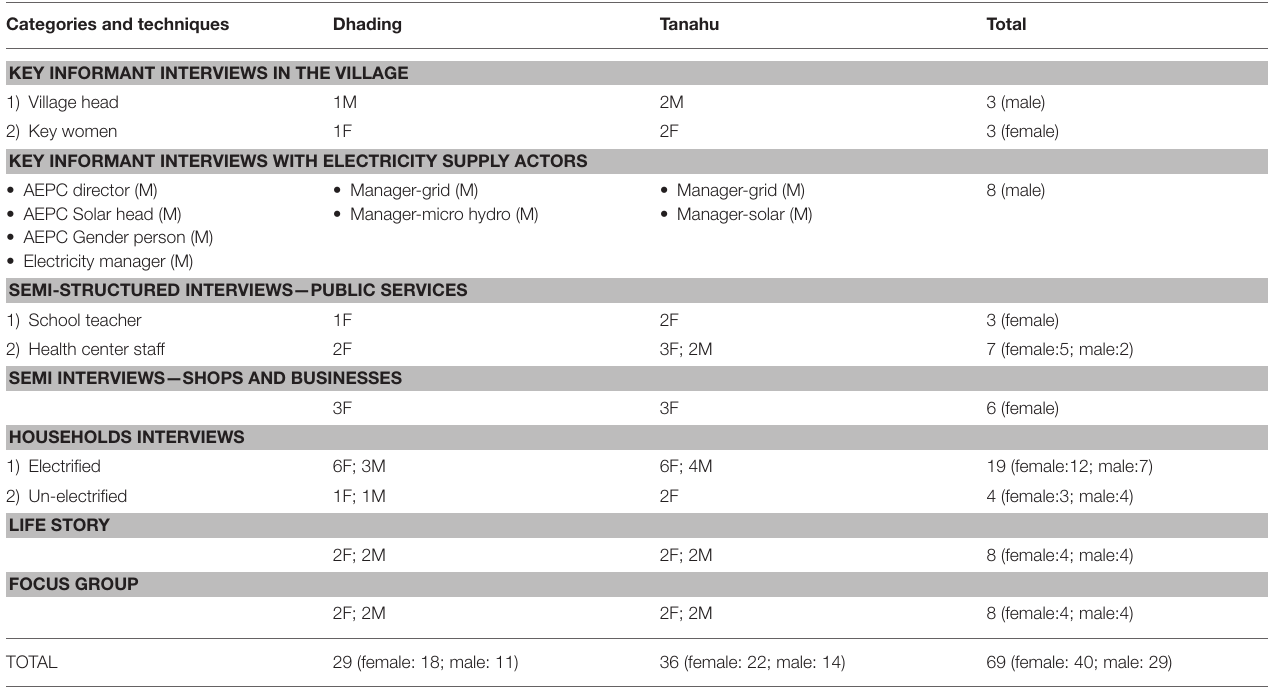
TABLE 1 | Techniques and persons interacted with for qualitative